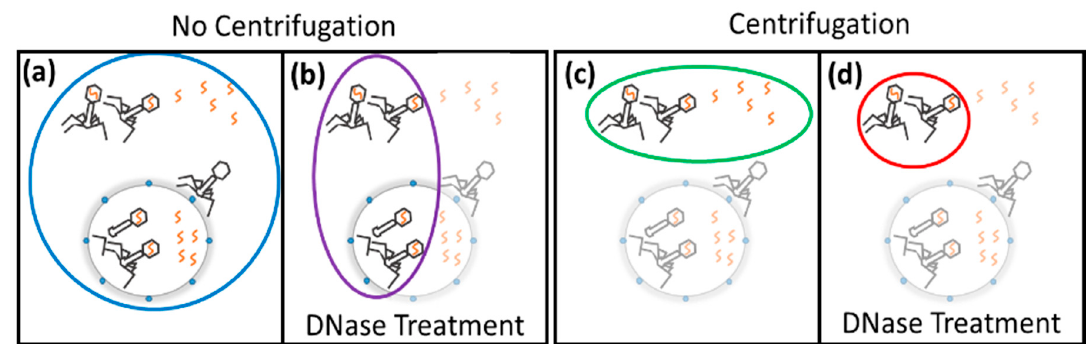
Figure 1. Modifying qPCR quantification to select for encapsidated and non-absorbed phage genomes. ( a ) Standard qPCR quantification will quantify all phage genomes and virions in solution. ( b ) DNase treatment selects only virions. ( c ) After centrifugation, the supernatant contains only non-adsorbed phage genomes and virions. ( d ) The use of centrifugation and DNase treatment selects non-adsorbed virions. The circles represent the selected genomes and the color of the circle corresponds to the curves of the MPI. Chloroform sampling is assumed to have been used for all qPCRs.